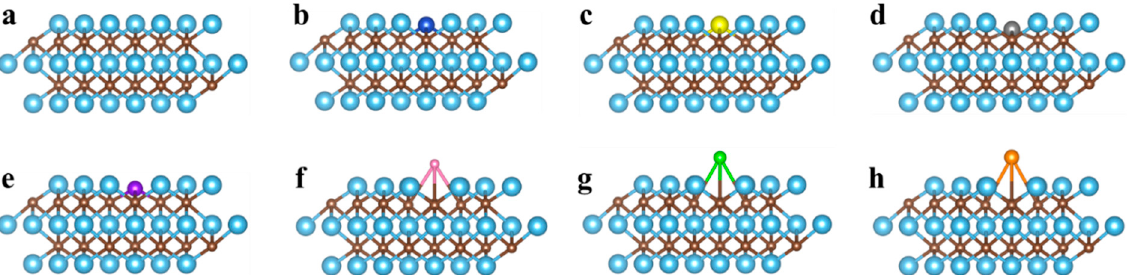
Figure 3. ( a ) Intrinsic Ti 3 C 2 relaxation side view, ( b ) Cu-doped Ti 3 C 2 configuration relaxation side view, ( c ) Pt-doped Ti3C2 configuration relaxation side view, ( d ) Co-doped Ti 3 C 2 configuration relaxation side view, ( e ) Si-doped Ti 3 C 2 configuration relaxation side view, ( f ) F-doped Ti 3 C 2 configuration relaxation side view, ( g ) Cl-doped Ti 3 C 2 configuration relaxation side view, ( h ) side view of the relaxation of the Br-doped Ti 3 C 2 configuration.